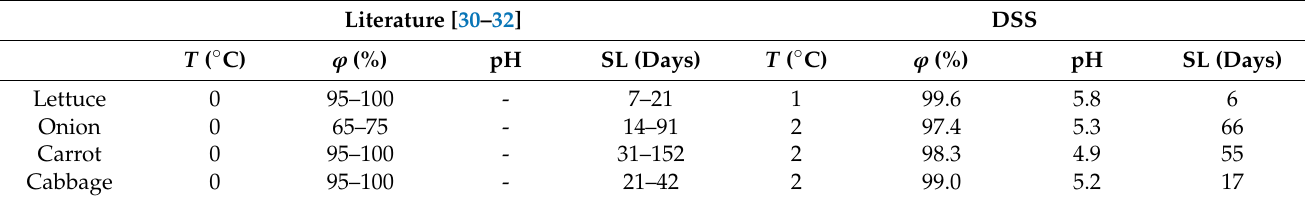
Table 10. Comparison between the shelf time values obtained by the DSS and the values collected in